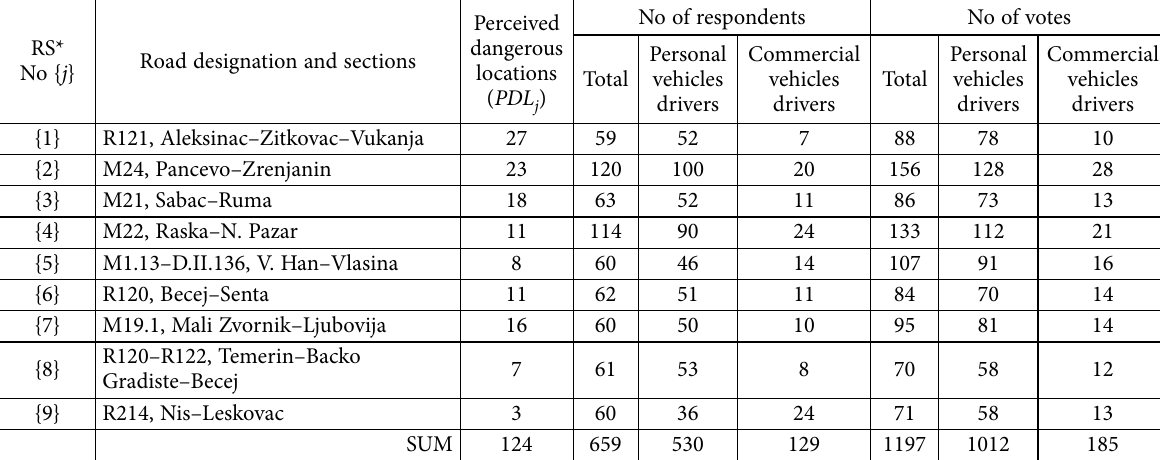
Table 1. Data on road sections on which the surveys were carried out, with main data on the sample, Black Spots and Perceived Dangerous Locations